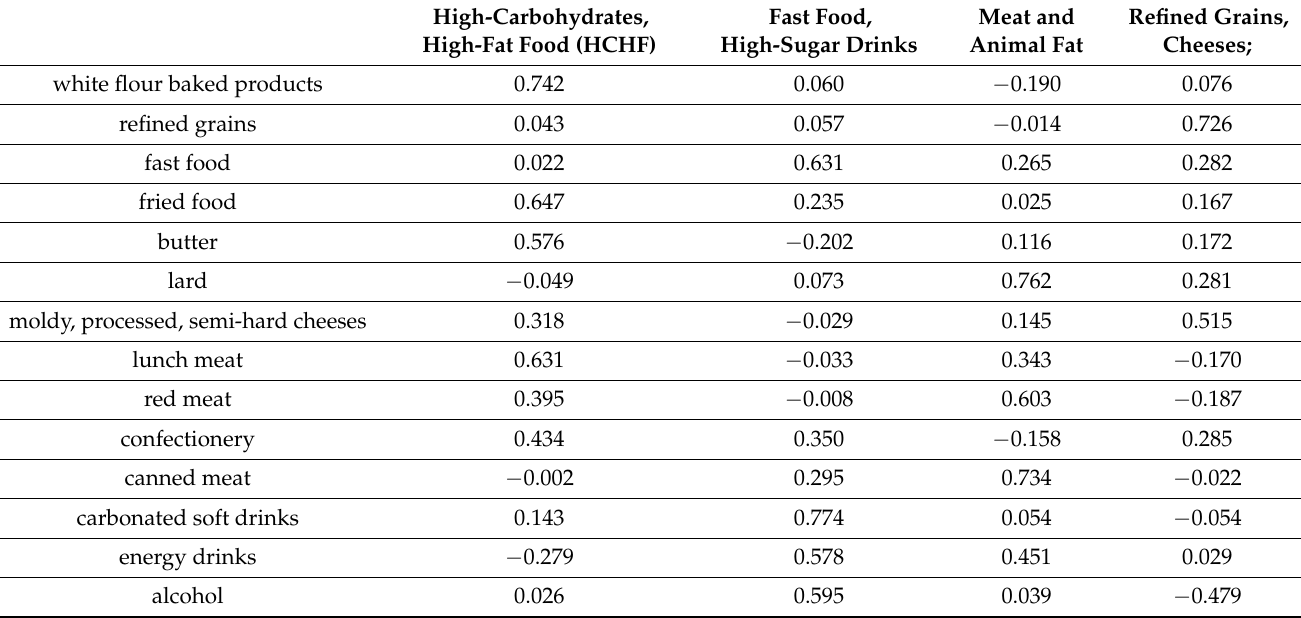
Table 3. Rotated component matrix of non-healthy food products. High-Carbohydrates, High-Fat Food (HCHF)